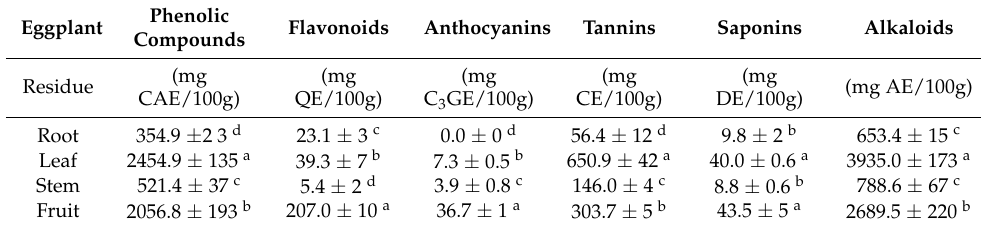
Table 2. Phytochemical composition of eggplant agricultural